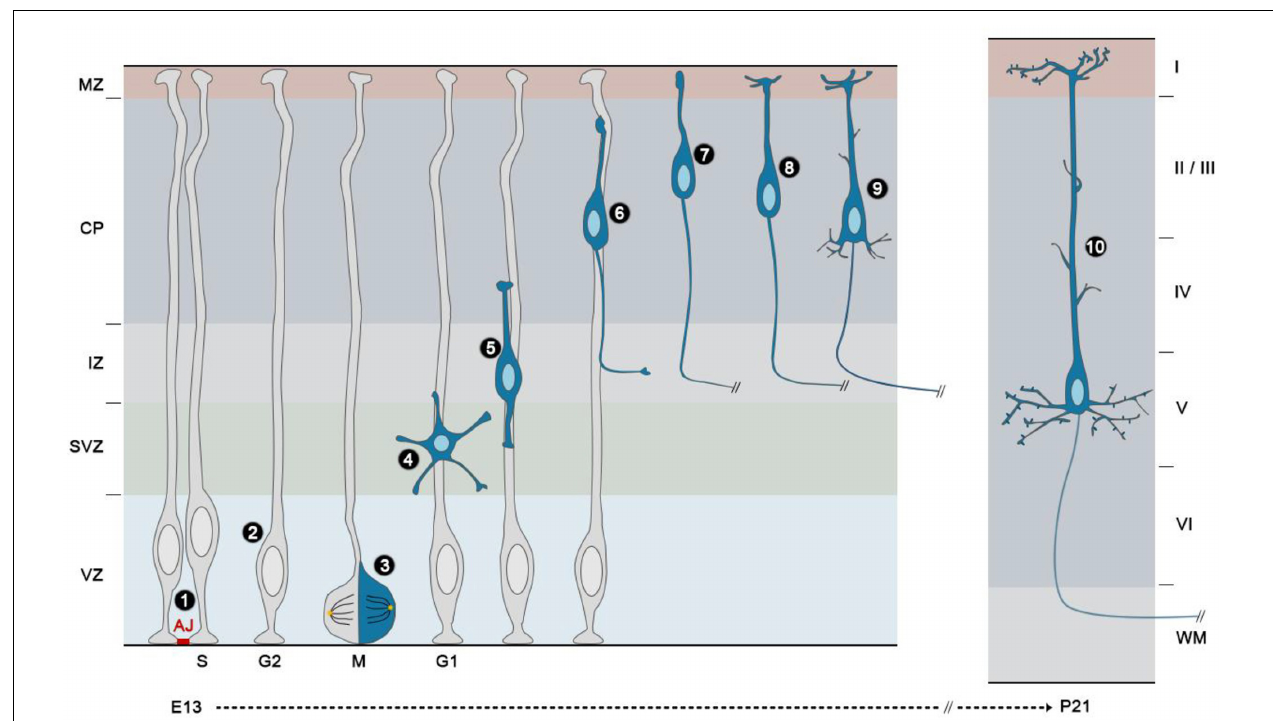
FIGURE 4 | Development of projection neurons in the mouse cerebral cortex. The neural stem/progenitor cells of the cerebral cortex or radial glial cells (RGs) are highly polarized cells that are attached to one another in the ventricular zone (VZ) by apically located adherens junctions (AJ) ❶ . Their nuclei migrate during cell cycle progression from a basal position during S phase to an apical position during mitosis (M), and the nuclei of the daughter cells migrate back to enter S phase on the basal side of the VZ, in a process called interkinetic nuclear migration (INM) ❷ . During the peak of neurogenesis, most radial glial cells divide asymmetrically with a vertical cleavage plane ❸ . In these divisions, one daughter remains a RG and continues to divide at the ventricular surface, whereas the other detaches from the ventricular surface, move radially away to the subventricular zone (SVZ)/lower intermediate zone (IZ) and acquires a multipolar shape ❹ . Then, nascent neurons become bipolar, extending a leading process toward the pial surface and a trailing process in the opposite direction ❺ . Upon multi to